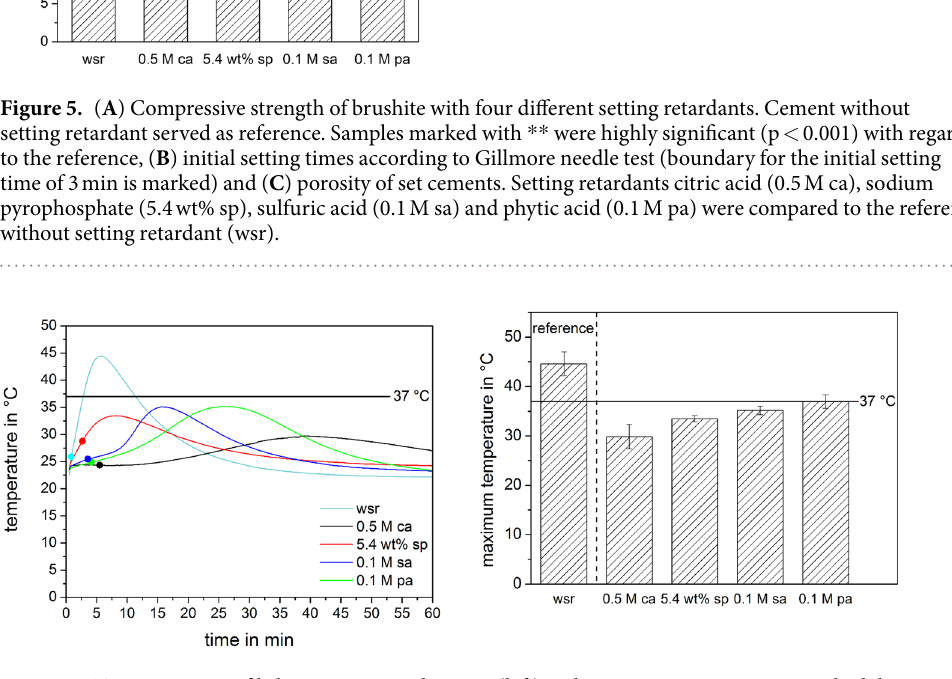
Figure 6. Temperature profile between 30 s and 60 min (left) and maximum temperature reached during setting (right). Samples with setting retardants citric acid (0.5 M ca), sodium pyrophosphate (5.4 wt% sp), sulfuric acid (0.1 M sa) and phytic acid (0.1 M pa) as well as a reference without setting retardant (wsr) ware examined. Dots mark the initial setting time determined by Gillmore needle